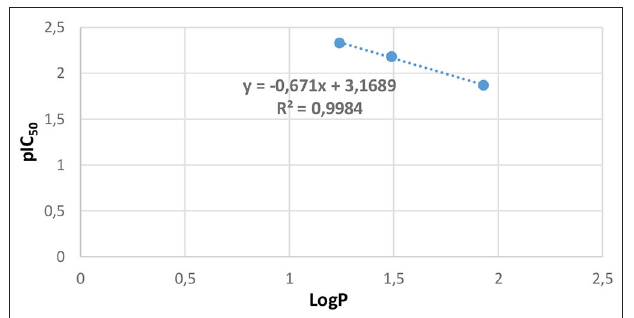
FIGURE 8 | Lipophilicity and antifungal activity plot.